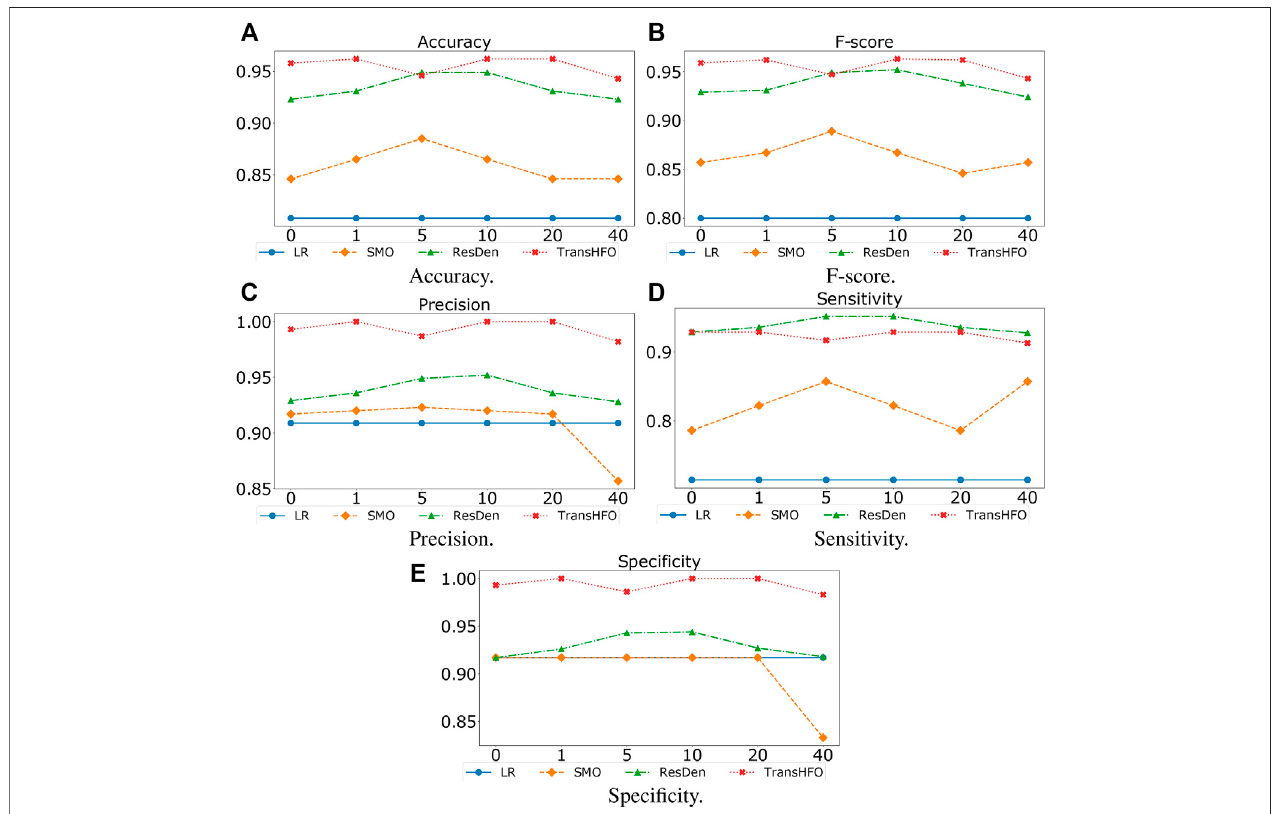
FIGURE3| Performance ofdifferentmodels withvaryingaugmentationfactors from0 to40.The modelshad betterperformancewith augmentation factors 5, 10, and 20. (A) Accuracy. (B) F-score. (C) Precision. (D) Sensitivity. (E) Speci fi city.